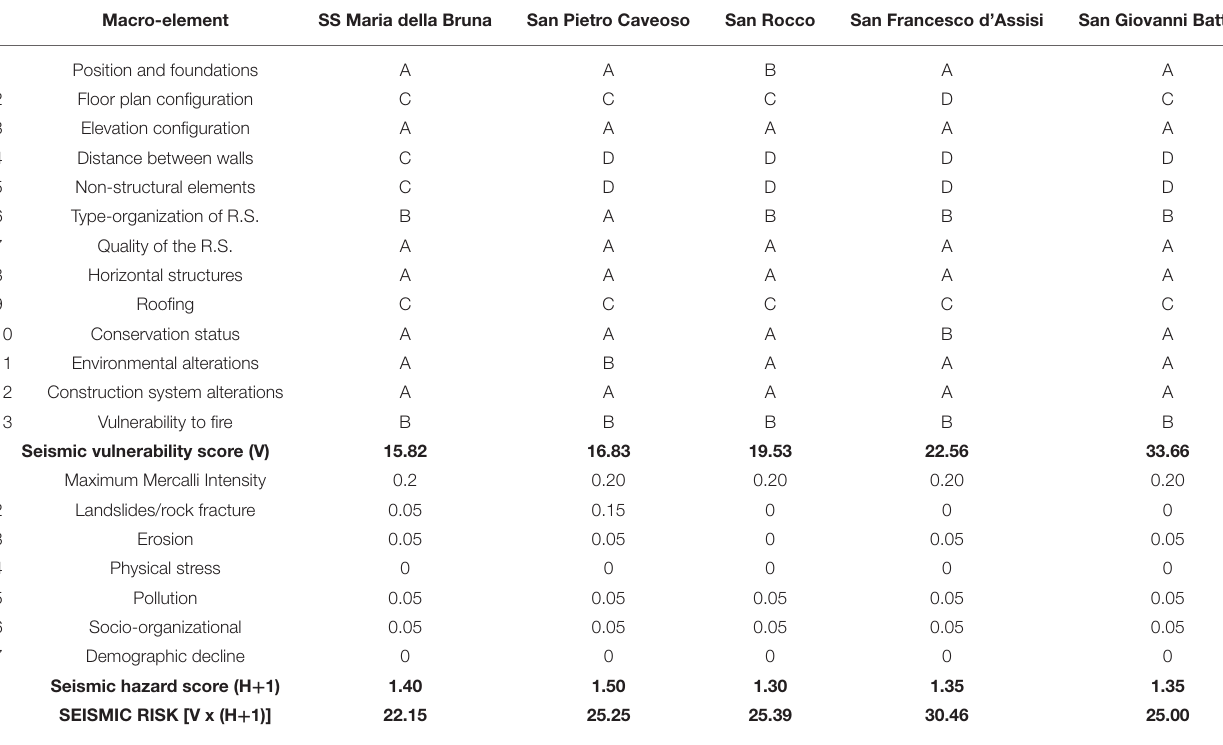
TABLE 6 | New simplified seismic risk assessment scoring (Dìaz, 2016).